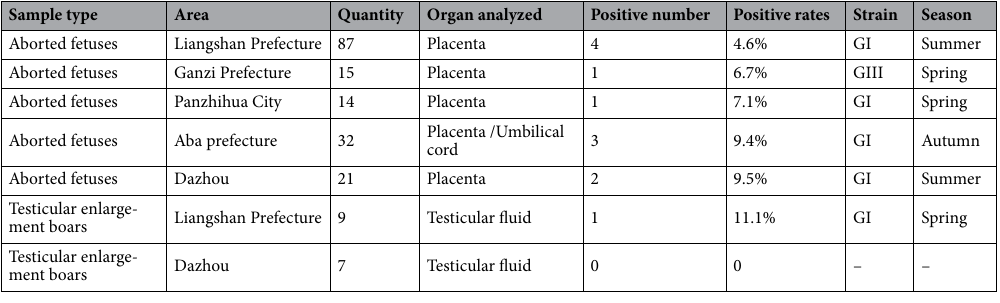
Table 1. Clinical samples test